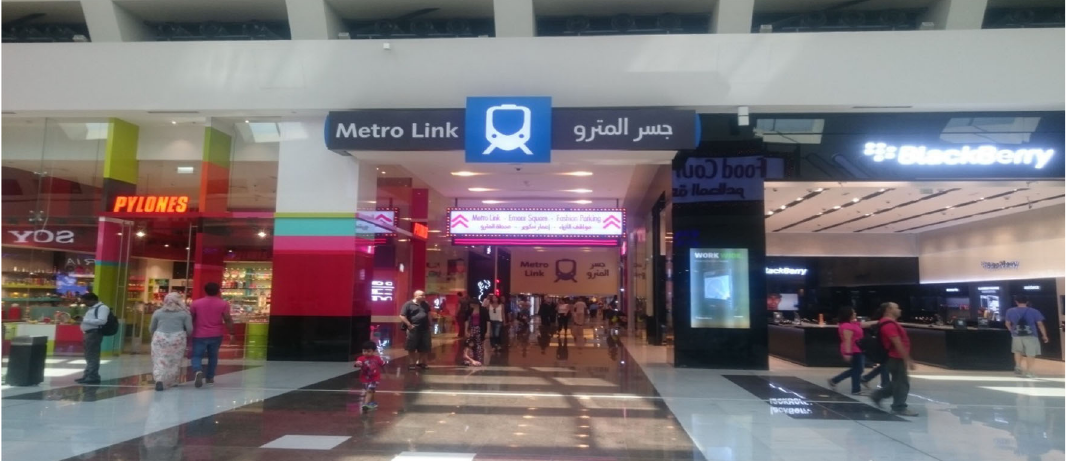
Fig. 6 Mall of the Emirates’ inside link to Dubai